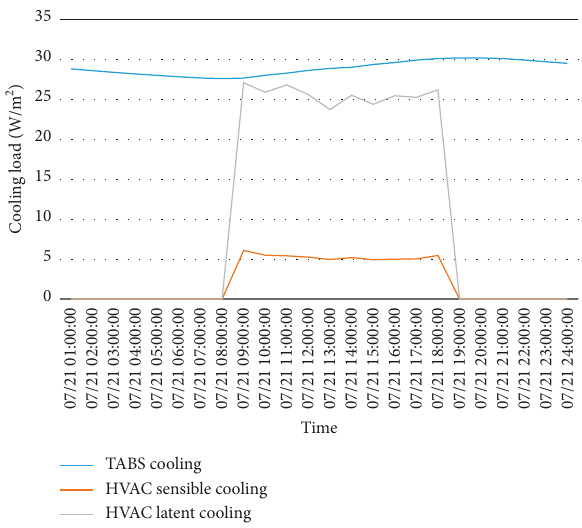
Figure 19: Amount of TABS and DOAS cooling in the lecture room with the proposed